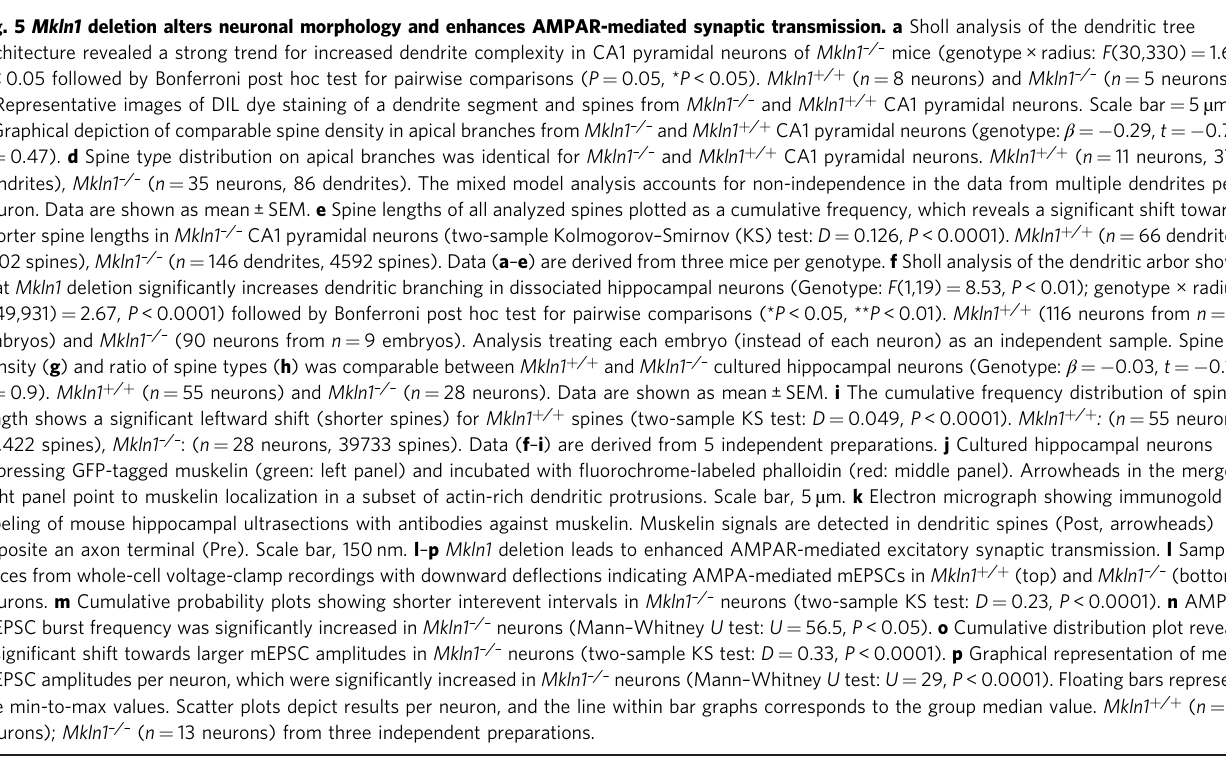
Fig. 5 Mkln1 deletion alters neuronal morphology and enhances AMPAR-mediated synaptic transmission. a Sholl analysis of the dendritic tree architecture revealed a strong trend for increased dendrite complexity in CA1 pyramidal neurons of Mkln1 – / – mice (genotype × radius: F (30,330) = 1.65, P < 0.05 followed by Bonferroni post hoc test for pairwise comparisons ( P = 0.05, * P < 0.05). Mkln1 + / + ( n = 8 neurons) and Mkln1 – / – ( n = 5 neurons). b Representative images of DIL dye staining of a dendrite segment and spines from Mkln1 – / – and Mkln1 + / + CA1 pyramidal neurons. Scale bar = 5 µ m. c Graphical depiction of comparable spine density in apical branches from Mkln1 – / – and Mkln1 + / + CA1 pyramidal neurons (genotype: β = − 0.29, t = − 0.72, P = 0.47). d Spine ty p e distribution on apical branches was identical for Mkln1 – / – and Mkln1 + / + CA1 pyramidal neurons. Mkln1 + / + ( n = 11 neurons, 37 dendrites), Mkln1 – / – ( n = 35 neurons, 86 dendrites). The mixed model analysis accounts for non-independence in the data from multiple dendrites per neuron. Data are shown as mean ± SEM. e Spine lengths of all analyzed spines plotted as a cumulative frequency, which reveals a signi fi cant shift towards shorter spine lengths in Mkln1 – / – CA1 pyramidal neurons (two-sample Kolmogorov – Smirnov (KS) test: D = 0.126, P < 0.0001). Mkln1 + / + ( n = 66 dendrites, 2202 spines), Mkln1 – / – ( n = 146 dendrites, 4592 spines). Data ( a – e ) are derived from three mice per genotype. f Sholl analysis of the dendritic arbor shows that Mkln1 deletion signi fi cantly increases dendritic branching in dissociated hippocampal neurons (Genotype: F (1,19) = 8.53, P < 0.01); genotype × radius: F (49,931) = 2.67, P < 0.0001) followed by Bonferroni post hoc test for pairwise comparisons (* P < 0.05, ** P < 0.01). Mkln1 + / + (116 neurons from n = 12 embryos) and Mkln1 – / – (90 neurons from n = 9 embryos). Analysis treating each embryo (instead of each neuron) as an independent sample. Spine density ( g ) and ratio of spine types ( h ) was comparable between Mkln1 + / + and Mkln1 – / – cultured hippocampal neurons (Genotype: β = − 0.03, t = − 0.12, P = length shows a signi fi cant leftward shift (shorter spines) for Mkln1 + / + spines (two-sample KS test: D = 0.049, P < 0.0001). Mkln1 + / + : ( n = 55 neurons, 73,422 spines), Mkln1 – / – : ( n = 28 neurons, 39733 spines). Data ( f – i ) are derived from 5 independent preparations. j Cultured hippocampal neurons expressing GFP-tagged muskelin (green: left panel) and incubated with fl uorochrome-labeled phalloidin (red: middle panel). Arrowheads in the merged right panel point to muskelin localization in a subset of actin-rich dendritic protrusions. Scale bar, 5 µ m. k Electron micrograph showing immunogold labeling of mouse hippocampal ultrasections with antibodies against muskelin. Muskelin signals are detected in dendritic spines (Post, arrowheads) opposite an axon terminal (Pre). Scale bar, 150 nm. l – p Mkln1 deletion leads to enhanced AMPAR-mediated excitatory synaptic transmission. l Sample traces from whole-cell voltage-clamp recordings with downward de fl ections indicating AMPA-mediated mEPSCs in Mkln1 + / + (top) and Mkln1 – / – (bottom) neurons. m Cumulative probability plots showing shorter interevent intervals in Mkln1 – / – neurons (two-sample KS test: D = 0.23, P < 0.0001). n AMPA- mEPSC burst frequency was signi fi cantly increased in Mkln1 – / – neurons (Mann – Whitney U test: U = 56.5, P < 0.05). o Cumulative distribution plot reveals a signi fi cant shift towards larger mEPSC amplitudes in Mkln1 – / – neurons (two-sample KS test: D = 0.33, P < 0.0001). p Graphical representation of mean mEPSC amplitudes per neuron, which were signi fi cantly increased in Mkln1 – / – neurons (Mann – Whitney U test: U = 29, P < 0.0001). Floating bars represent the min-to-max values. Scatter plots depict results per neuron, and the line within bar graphs corresponds to the group median value. Mkln1 + / + ( n = 16 neurons); Mkln1 – / – ( n = 13 neurons) from three independent